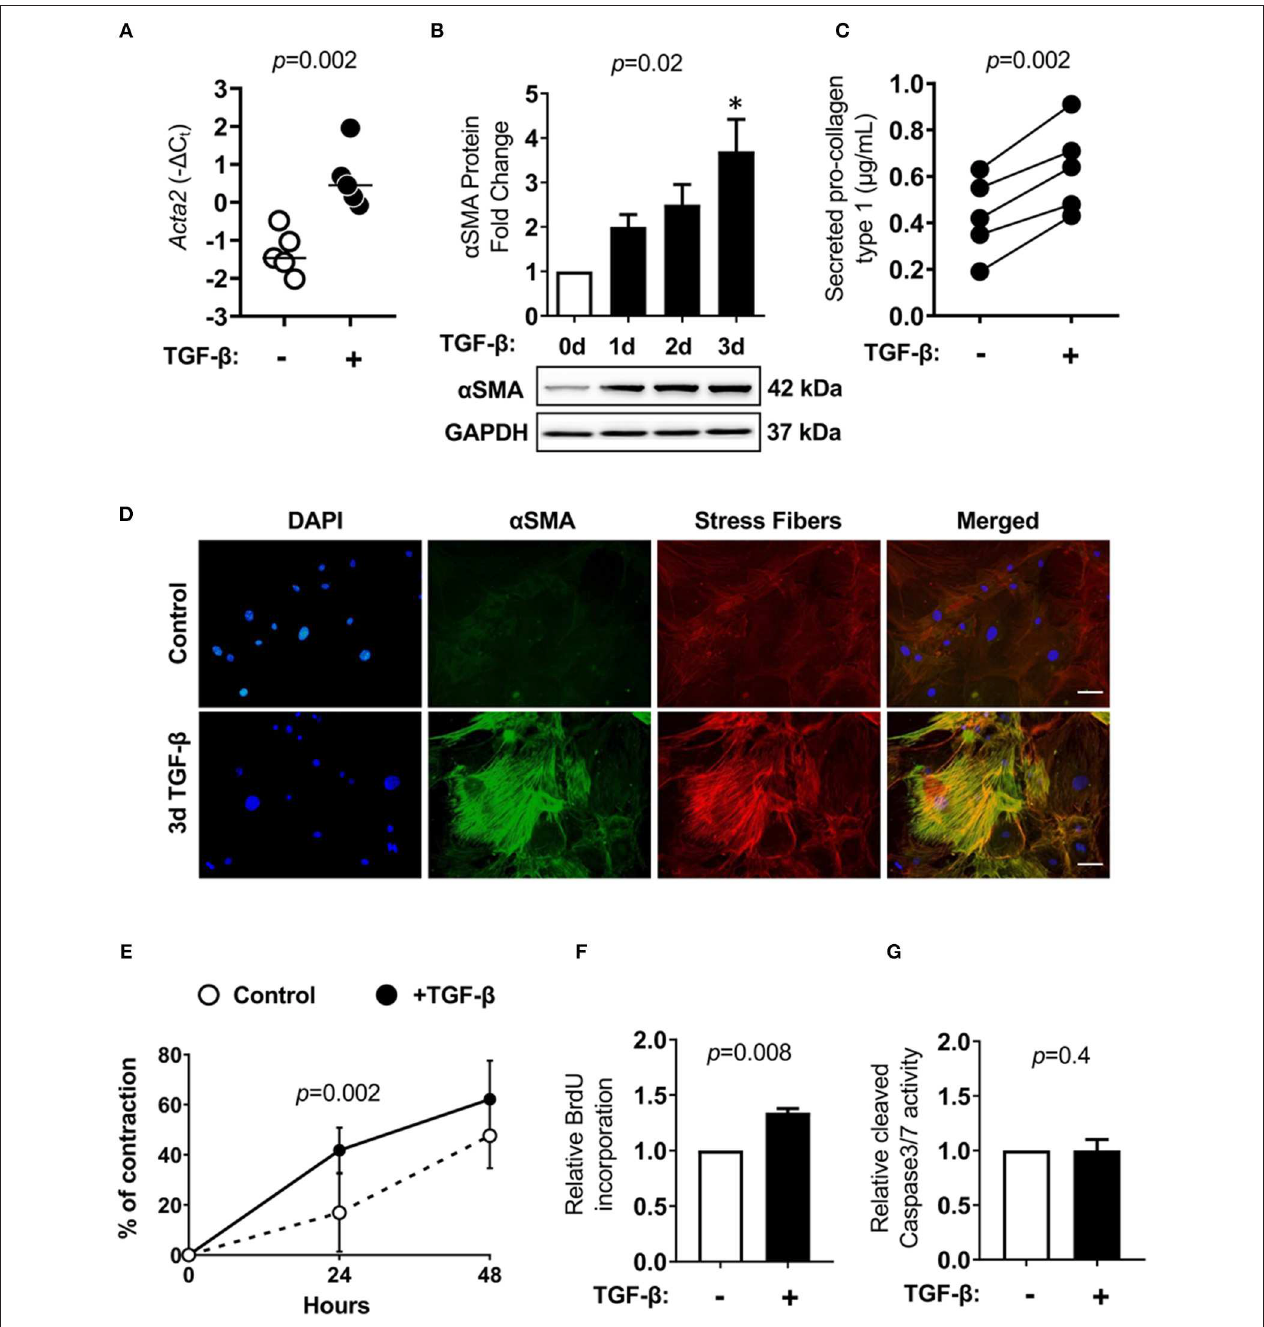
FIGURE 5 | Cardiac Lin − gp38 + cells response to TGF- β 1 stimulation. Cardiac Lin − gp38 + cells were isolated from hearts of C57BL/6 mice as described in Figure 1 and expanded in vitro . (A) Shows Acta2 mRNA expression in cardiac Lin − gp38 + cells cultured in the presence or absence of TGF- β 1 (10 ng/mL) for 24 h ( n = 5, p -value calculated with Mann-Whitney U -test). (B) Shows quantification and representative immunoblots for α SMA protein levels in lysates of Lin − gp38 + cells cultured in the presence or absence of TGF- β 1 (10ng/mL) for the indicated time [ n = 5, p -values computed using Kruskal-Wallis test followed by the Dunn’s multiple comparisons test, * p < 0.05 ( post-hoc test vs. control)]. In (C) , results from ELISA for pro-collagen type 1 are presented. Lin − gp38 + cells were seeded at passage 3 and treated with or without TGF- β 1 (10ng/mL) for 7 days. Supernatants were used to assess the amount of pro-collagen type 1 secreted from Lin − gp38 + cells ( n = 5, p -value calculated with paired t -test). (D) Shows representative staining of α SMA (green) and phalloidin (red) in Lin − gp38 + cells cultivated in the presence or absence of TGF- β 1 (10ng/mL) for 3 days. DAPI stains cell nuclei. Bar = 50 µ m. (E) Shows quantification of Lin − gp38 + cells contractility precultured in the presence or absence of TGF- β 1 (10ng/mL) for 3 days ( n = 6, p -value calculated with Sidak’s multiple comparison test). (F) Indicates quantification of BrdU incorporation by Lin − gp38 + cells cultured in the presence or absence of TGF- β 1 (10ng/mL) for 24h ( n = 5, p -value calculated with Mann-Whitney U -test). (G) Shows quantification